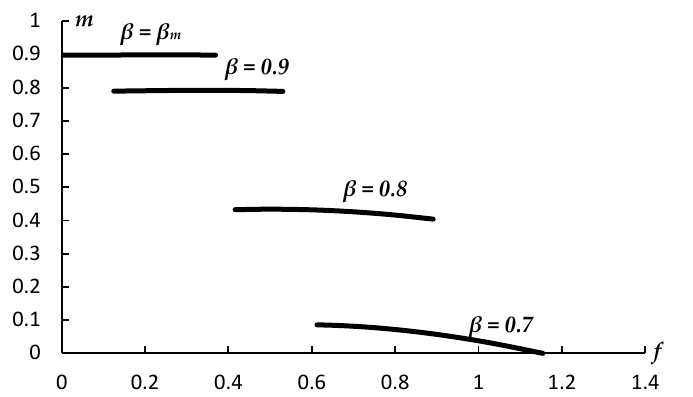
Figure 6. Loading paths in the ( f, m ) space for several β values. Design (a) requires a numerical method for solving Equations (41) and (43). This solution has shown that both designs lead to practically the same dependence of f on a . Therefore, this dependence is not illustrated for Design ( a ). The variation of m with a slightly depends on the design objectives. Figure 7 compares the two designs ( β ∗ = β m and β = β m in Figure 7a, β ∗ = 0.9 and β = 0.9 in Figure 7b, β ∗ = 0.8 and β = 0.8 in Figure 7c, and β ∗ = 0.7 and β = 0.7 in Figure 7d). The solid curves correspond to Design ( a ) and the broken curves to Design ( b ). The difference decreases as the desired final thickness decreases and becomes invisible in Figure 7c, and Figure 7d.